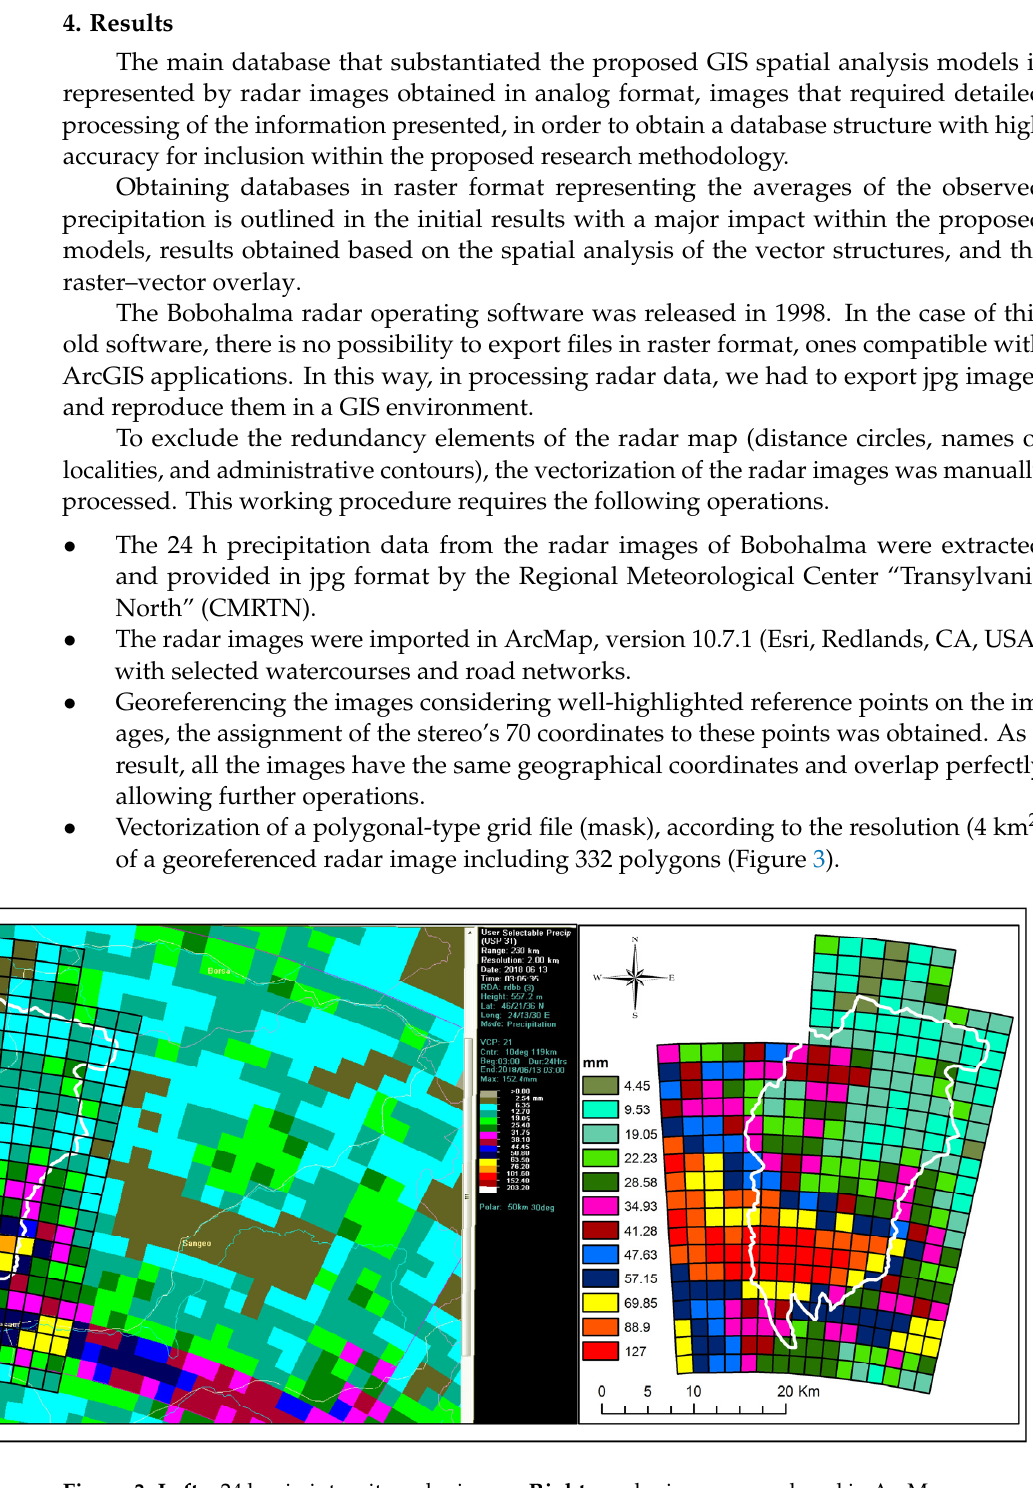
Figure 3. Left —24 h rain intensity radar image. Right —radar image reproduced in ArcMap, an event from 13 June 2018.